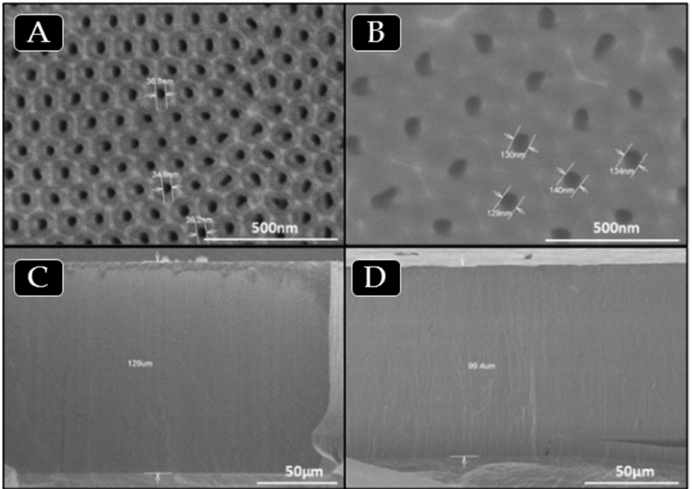
Figure 1. SEM images of AAO templates obtained with oxalic acid solution ( a , c ) and phosphoric acid ( b , d ) as electrolytes, respectively. Surface view of templates with 35 ( a ) and 140 ( b ) nanometers of pore diameter and cross section view of templates ( c , d ), where the length is around 100 µ m, see values in Table